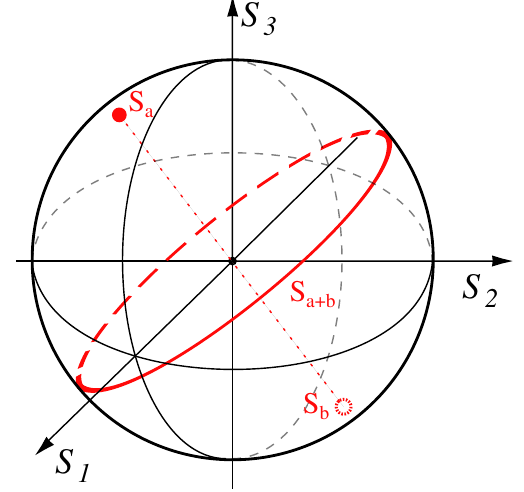
FIG. 1. Combination of radiation pulses with orthogonal polarization basis S a and S b , represented on Poincar´e sphere, yields polarization states located on a big circle of sphere.